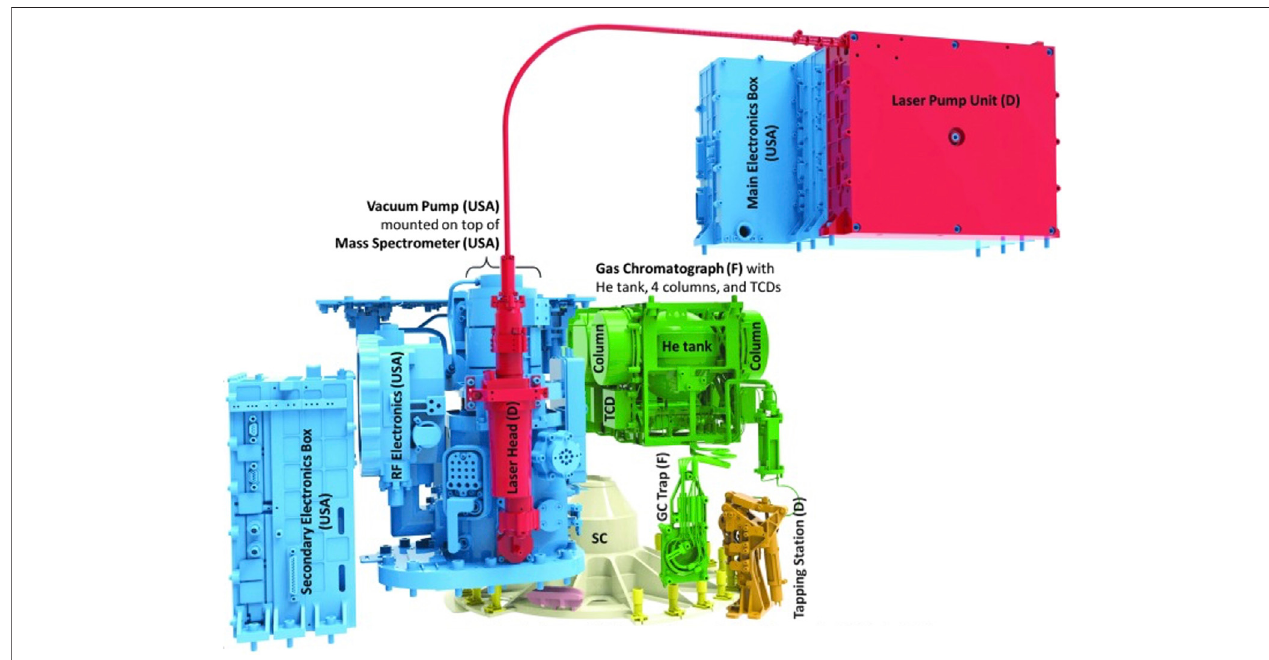
FIGURE2| ThedifferentpartsofMOMAinstrumentwiththecountrycontributing[UnitedStates(USA),France(F),Germany(D)]areillustrated.Thesamplecarousel (SC) is composed of 32 ovens (represented in yellow on the fi gure) for pyrolysis and derivatization. The re fi llable sample container (holding the sample for LDMS, represented in light pink) and the sample carousel are not part of MOMA (credit: Max-Planck Institute, NASA).